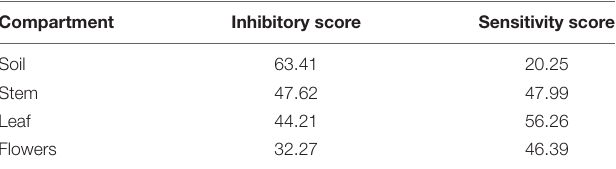
TABLE 6 | Inhibitory and sensitivity score of the endophytic bacteria associated to the four compartments of O. vulgare . Compartment